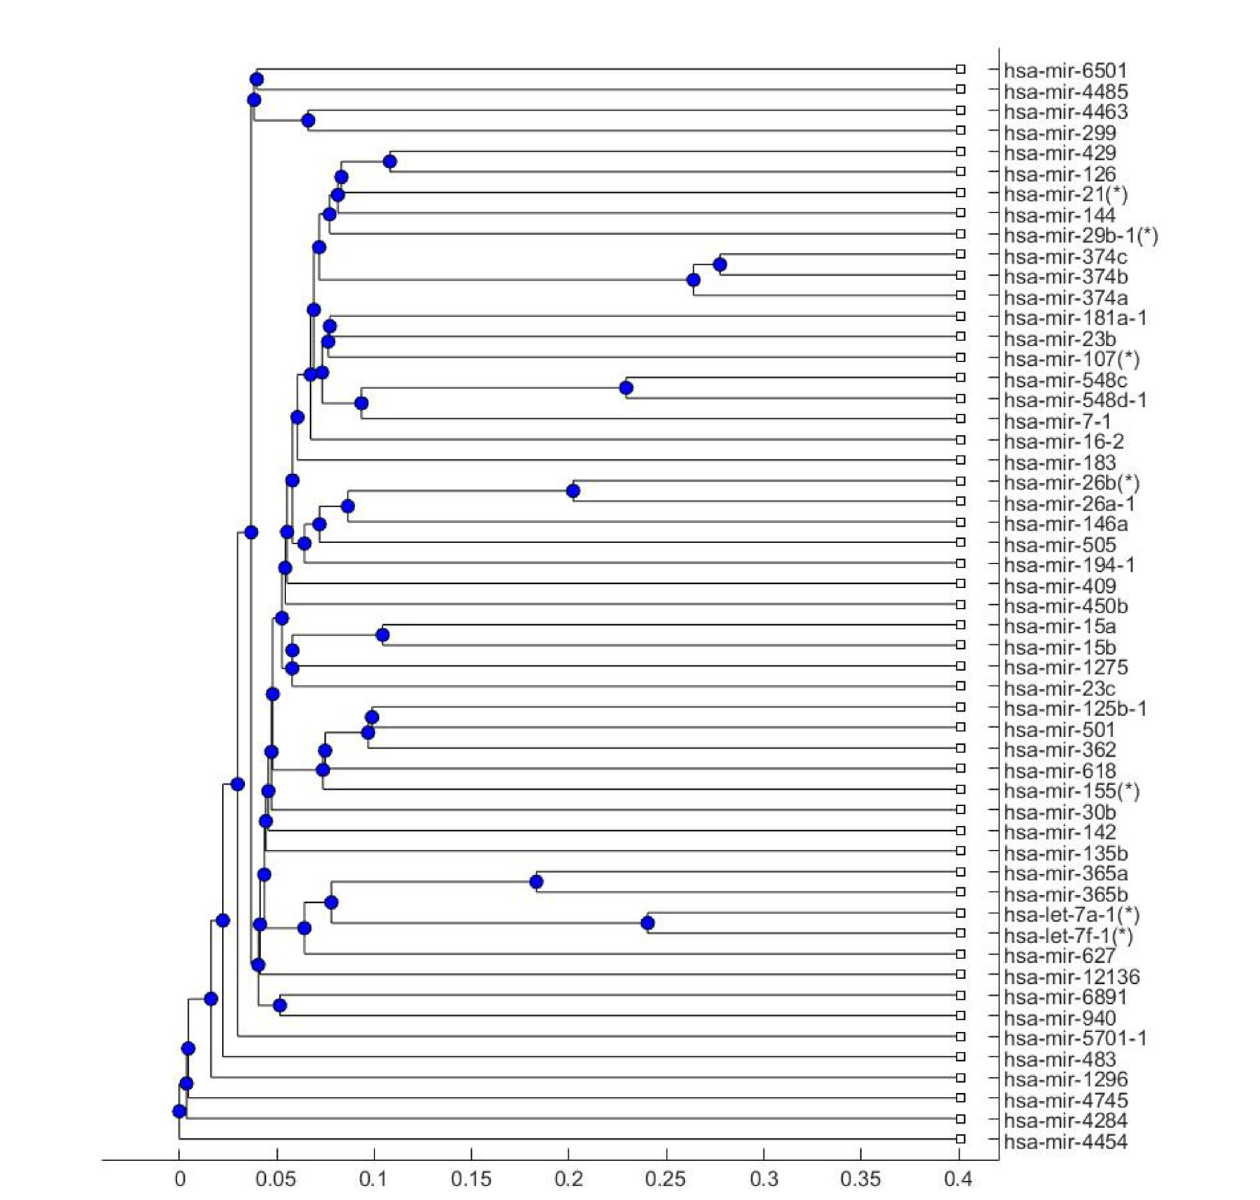
FIGURE 4 | Phylogenetic tree of human COVID-19 miRNA biomarkers. The seven common miRNAs are marked with